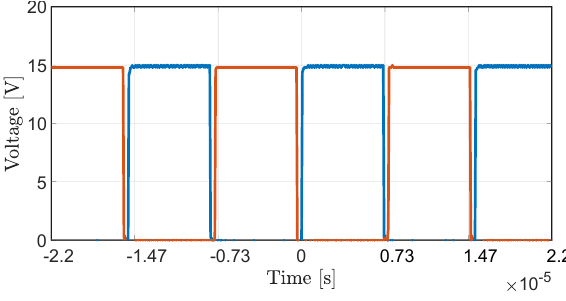
Figure 13. The gate to source voltages to the MOSFETs.